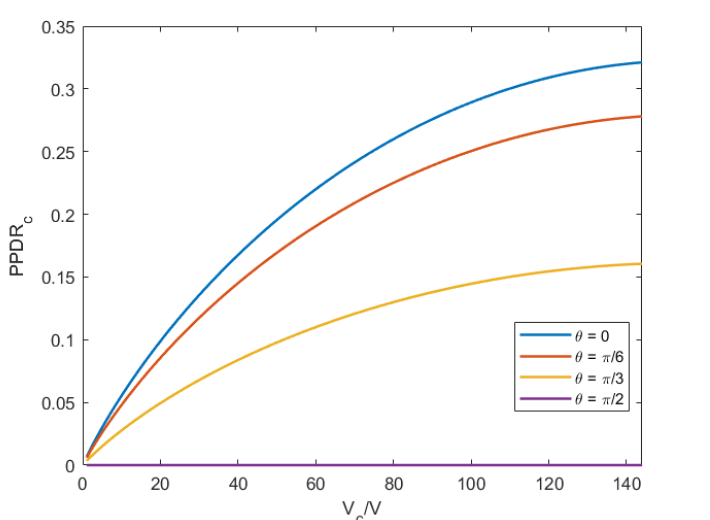
Figure 4. Influence of V c and θ on the electrical charge increment. As is shown in Figure 4, by increasing the super capacitor voltage and load power factor, the value of PPDR c keeps increasing. It is inevitable that the PPDR c is determined by the specific operation point in LSPWM. In this paper, hybrid modulation method is proposed to control power flow between ports